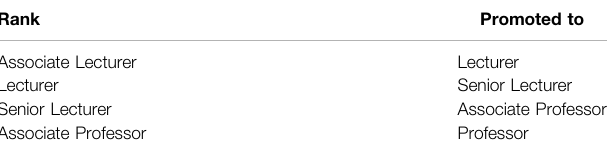
TABLE 2 | Hierarchy of academic